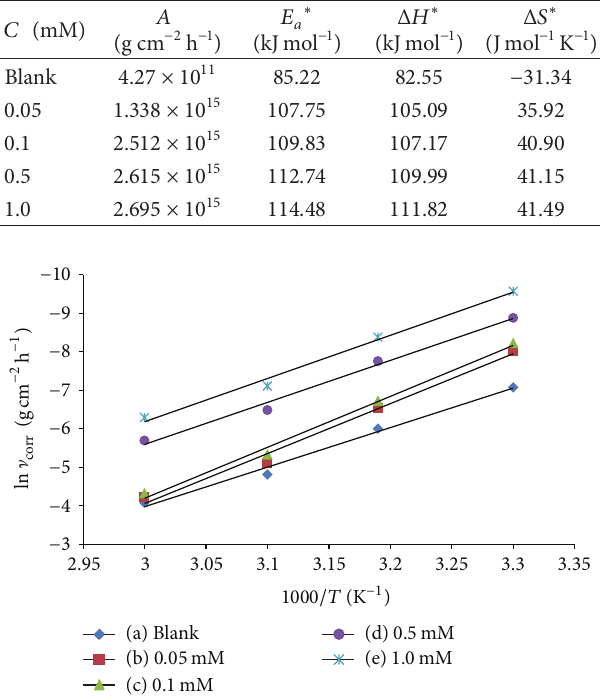
Figure 5: Arrhenius plot for mild steel in 1M HCl solution with RS at different